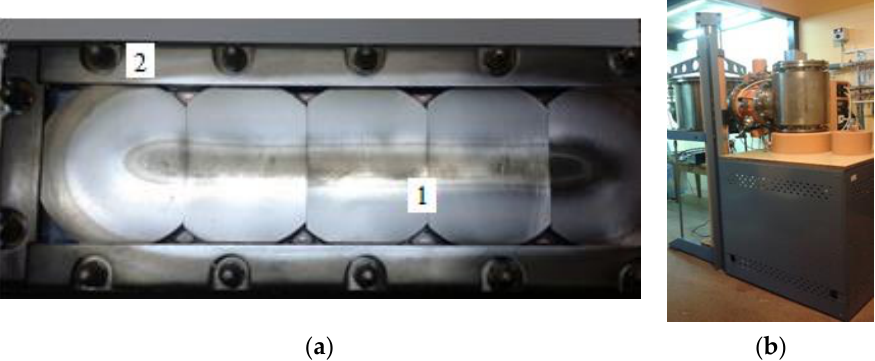
Figure 4. Magnetron sputtering stage: ( a ) linear magnetron (1—Si-Ti sinters, 2—fixtures for fixing sinters); ( b ) vacuum station.